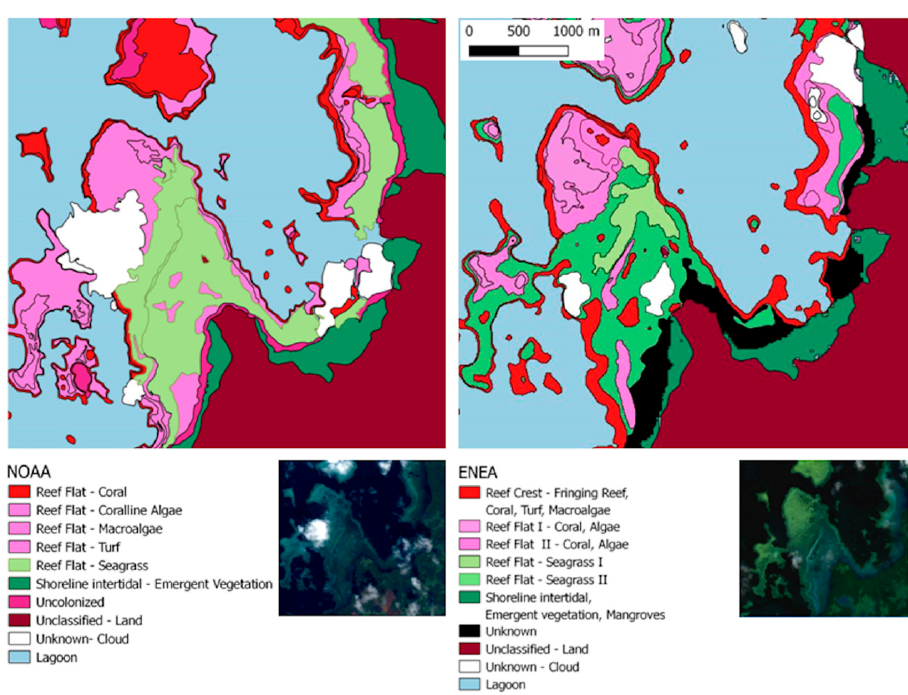
Figure 10. Comparison between habitat classifications in the Coastal Reef zone (site no. 2, see Figure 1). On the left, NOAA’s map and 2004 Ikonos imagery (informative layers downloaded from https: // products.coastalscience.noaa.gov / collections / benthic / e102palau / ); on the right, present work (ENEA) habitat map and 2017 Sentinel-2 imagery.